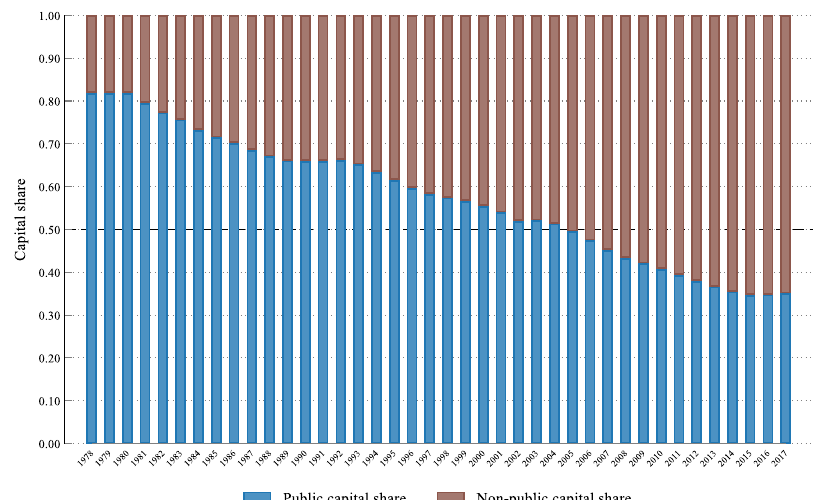
Figure 3. Analysis of capital share.